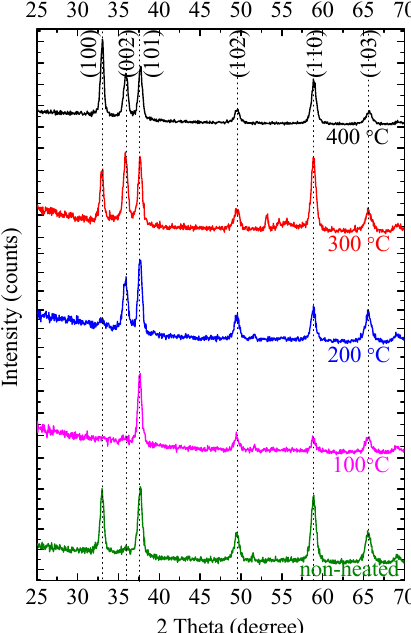
Figure 7. Grazing incidence X-ray diffraction (GIXRD) pattern of AlN:Er films prepared at various substrate temperatures. Note that the spectra have been shifted vertically for clarity purposes.